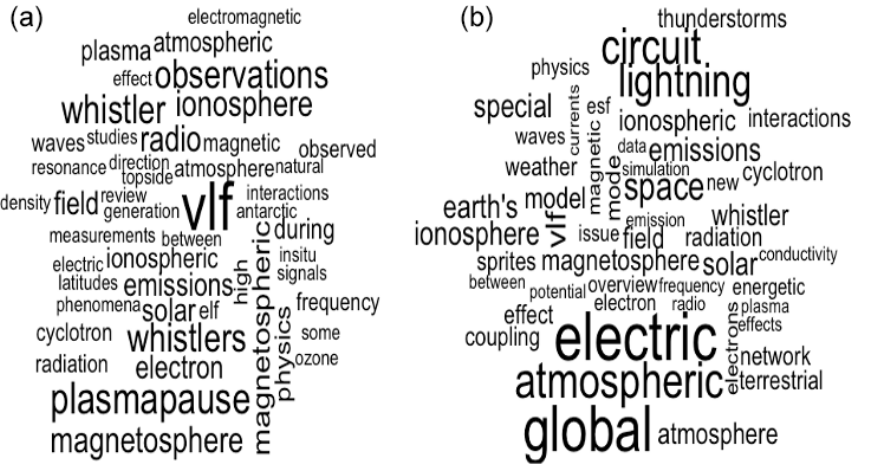
Figure 4. The most popular 50 words from Rycroft paper titles (a) 1964–1990 and (b) 1991–2018, printed at a size proportional to their rate of occurrence.